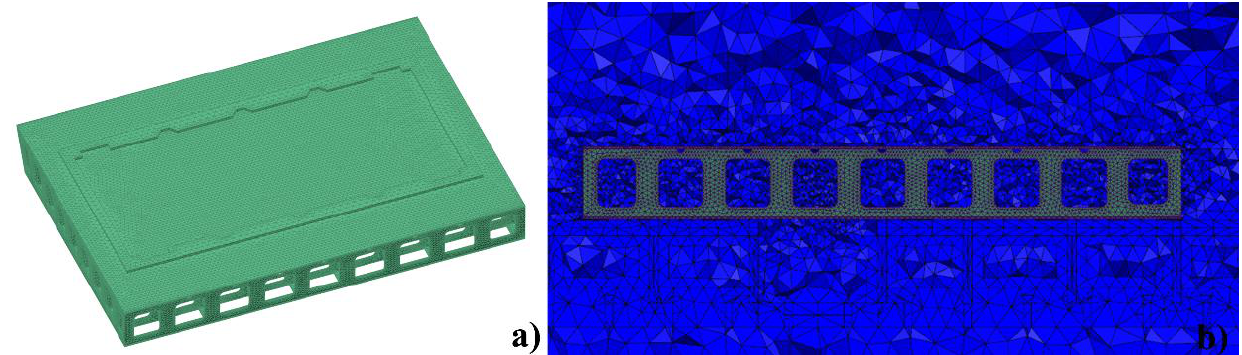
Figure 6. ( a ) Mesh of the mold; ( b ) Fluid – solid coupled mesh.